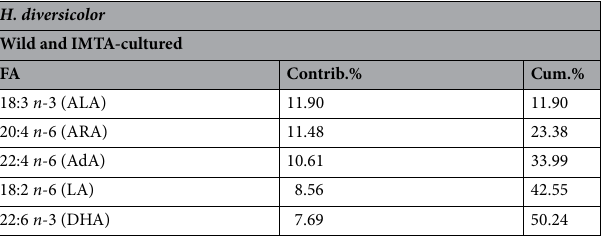
Table 2. SIMPER overall average dissimilarities (%) between fatty acids (FA) profile of wild and cultured polychaete Hediste diversicolor . AdA adrenic acid, ALA alpha-linolenic acid, ARA arachidonic acid, DHA docosahexaenoic acid, LA linoleic